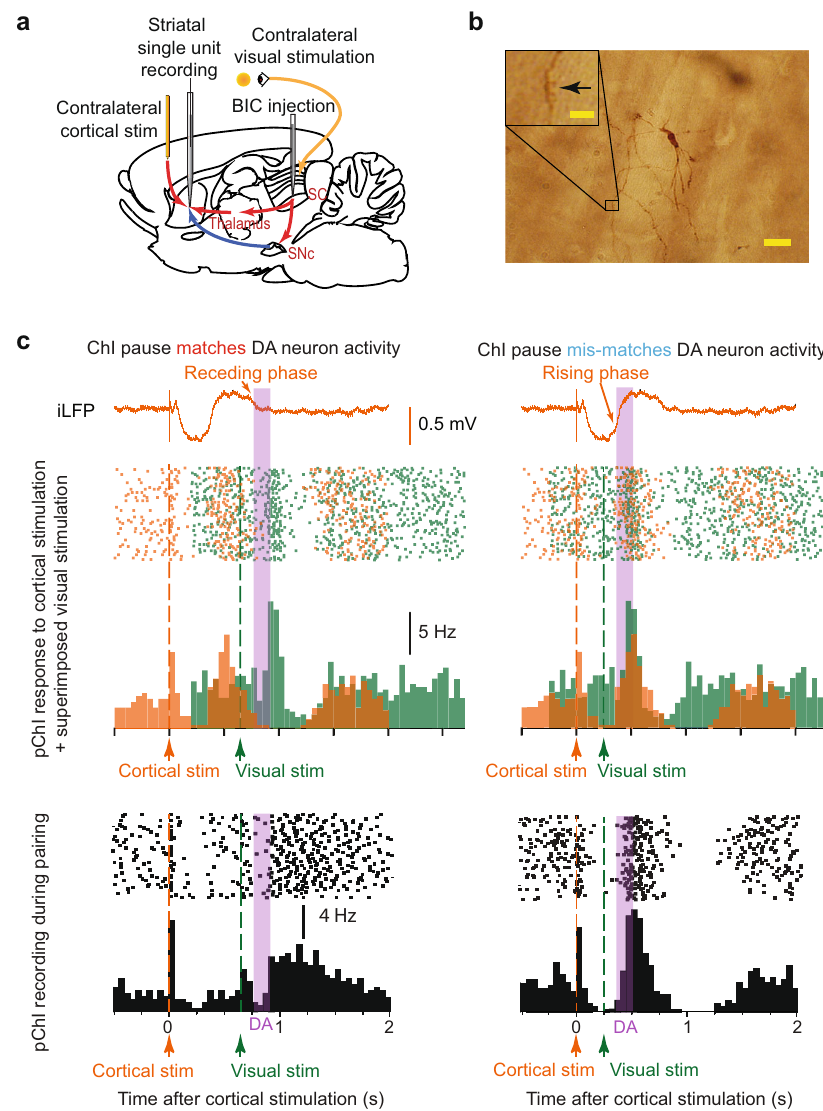
Fig. 1 Experimental paradigm to induce coincident ChI pause, dopamine activation and depolarisation. a Cortical stimulation was applied to elicit spike activity in SPNs and to entrain the activity of pChIs. Contralateral visual stimulation was applied with BIC injected into the SC to activate dopamine neurons and depolarise SPNs. b A representative example from 11 labelled SPNs with spine arrowed in inset (Scale bar 20 µ m; inset 5 µ m). c Upper , Cortical stimulation alone entrained the fi ring pattern of a pChI (orange raster and histogram). The excitation phase of the pChI occurs at the rising phase of the iLFP (orange trace), and the pause phase occurs at receding phases of the iLFP. Superimposed is the pChI response to the visual stimulation alone (green) with the SC disinhibited, and the likely period of released dopamine following visual activation indicated (purple). The visual stimulation is aligned to the timing used for pairing in the lower panels to illustrate the effect of the alignment. Because the excitation induced by the visual stimulation is very slow, it did not interfere with the pause induced by the critical stimulation. Lower , pairing cortical stimulation and visual stimulation at different intervals can drive phasic dopamine activity to coincide with either a ChI pause ( left ) or excitation phase ( right ). Note, due to the dif fi culties of recording pChI in vivo, three different pChIs were recorded to demonstrate how cortical stimulation alone ( upper, orange ), or visual stimulation alone ( upper, green ), or pairing of two stimuli ( lower ) regulate the fi ring pattern of pChIs,